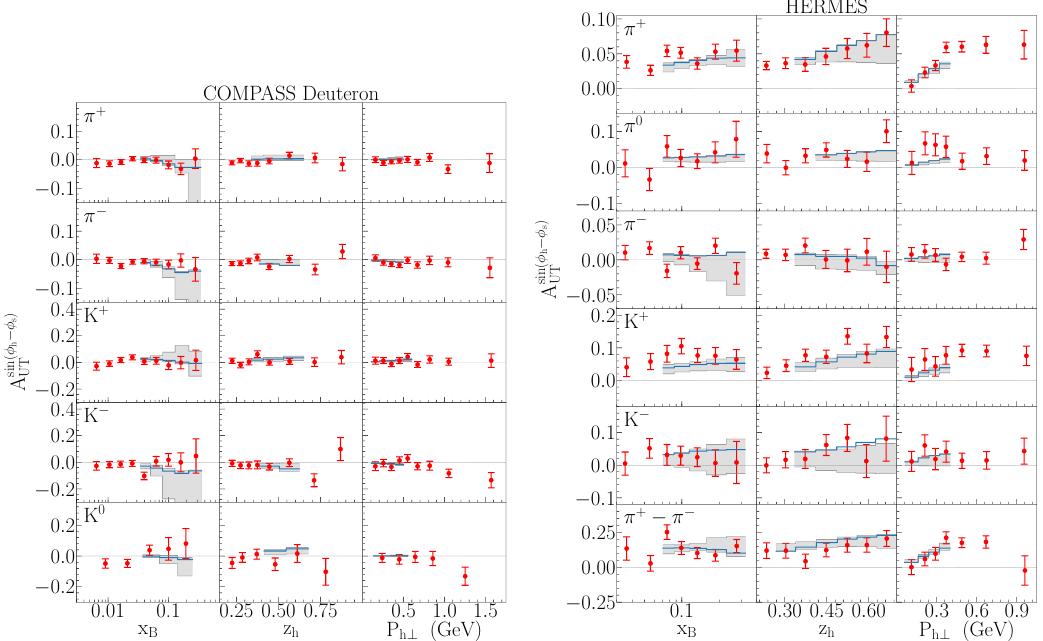
Figure 16 . Left: the COMPASS deuteron target measurement [44] for π + , π − , K + , K − , and K 0 from top to bottom, and as a function of x B (left), z h (middle), and P h ⊥ (right). Right: HERMES proton target measurement [41] π + , π 0 , π − , K + , K − , and ( π + − π − ) from top to bottom, and as a function of x B (left), z h (middle), and P h ⊥ (right). The data is plotted in red along with the total experimental error. The central curve in blue as well as the uncertainty band in gray are generated using the result from fit 2b in table